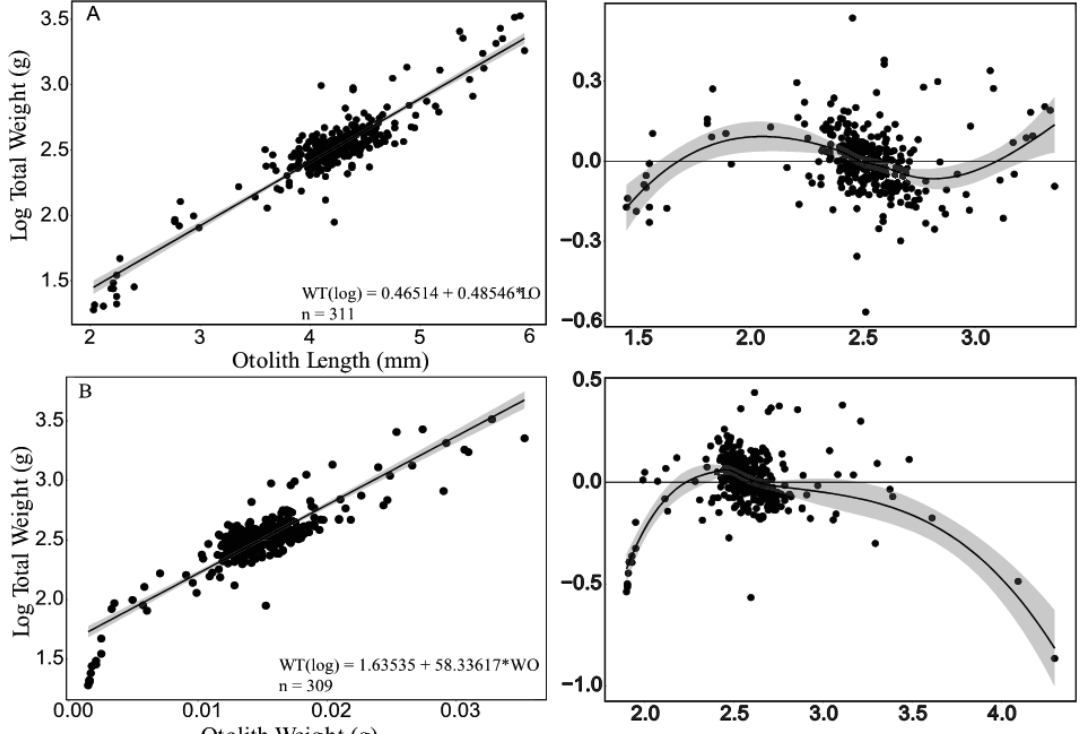
Fig. 4. Fits between lapillus otolith measures and the weight of Prochilodus lineatus : a. Otolith Length (r 2 = 0.85) and b. Otolith Wei- ght (r 2 = 0.78); the shaded area represents the confidence interval of 95% of the estimate; loess fit of raw residuals are in right